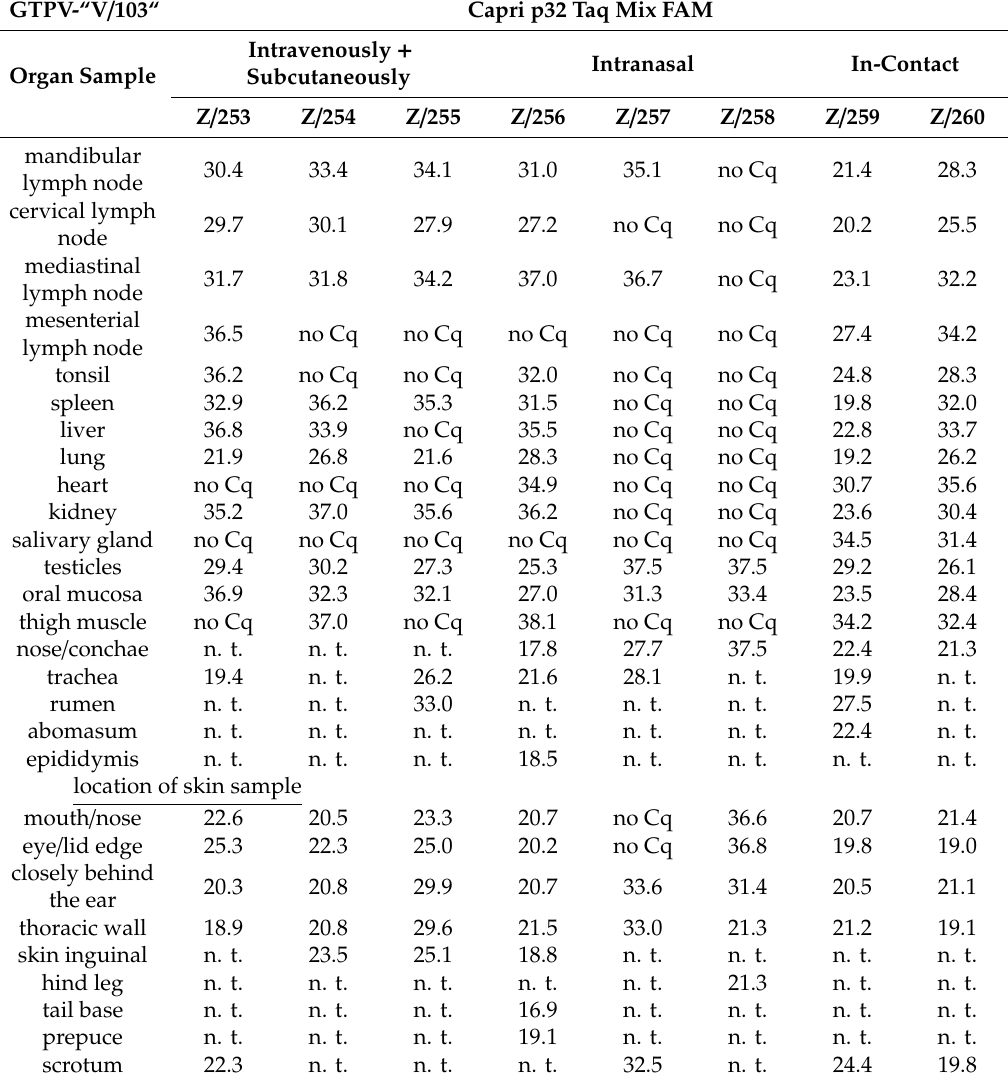
Table 3. Results (Cq values) of particular organ samples taken during section from goats infected with GTPV-“V / 103” analyzed using pan Capripox real-time